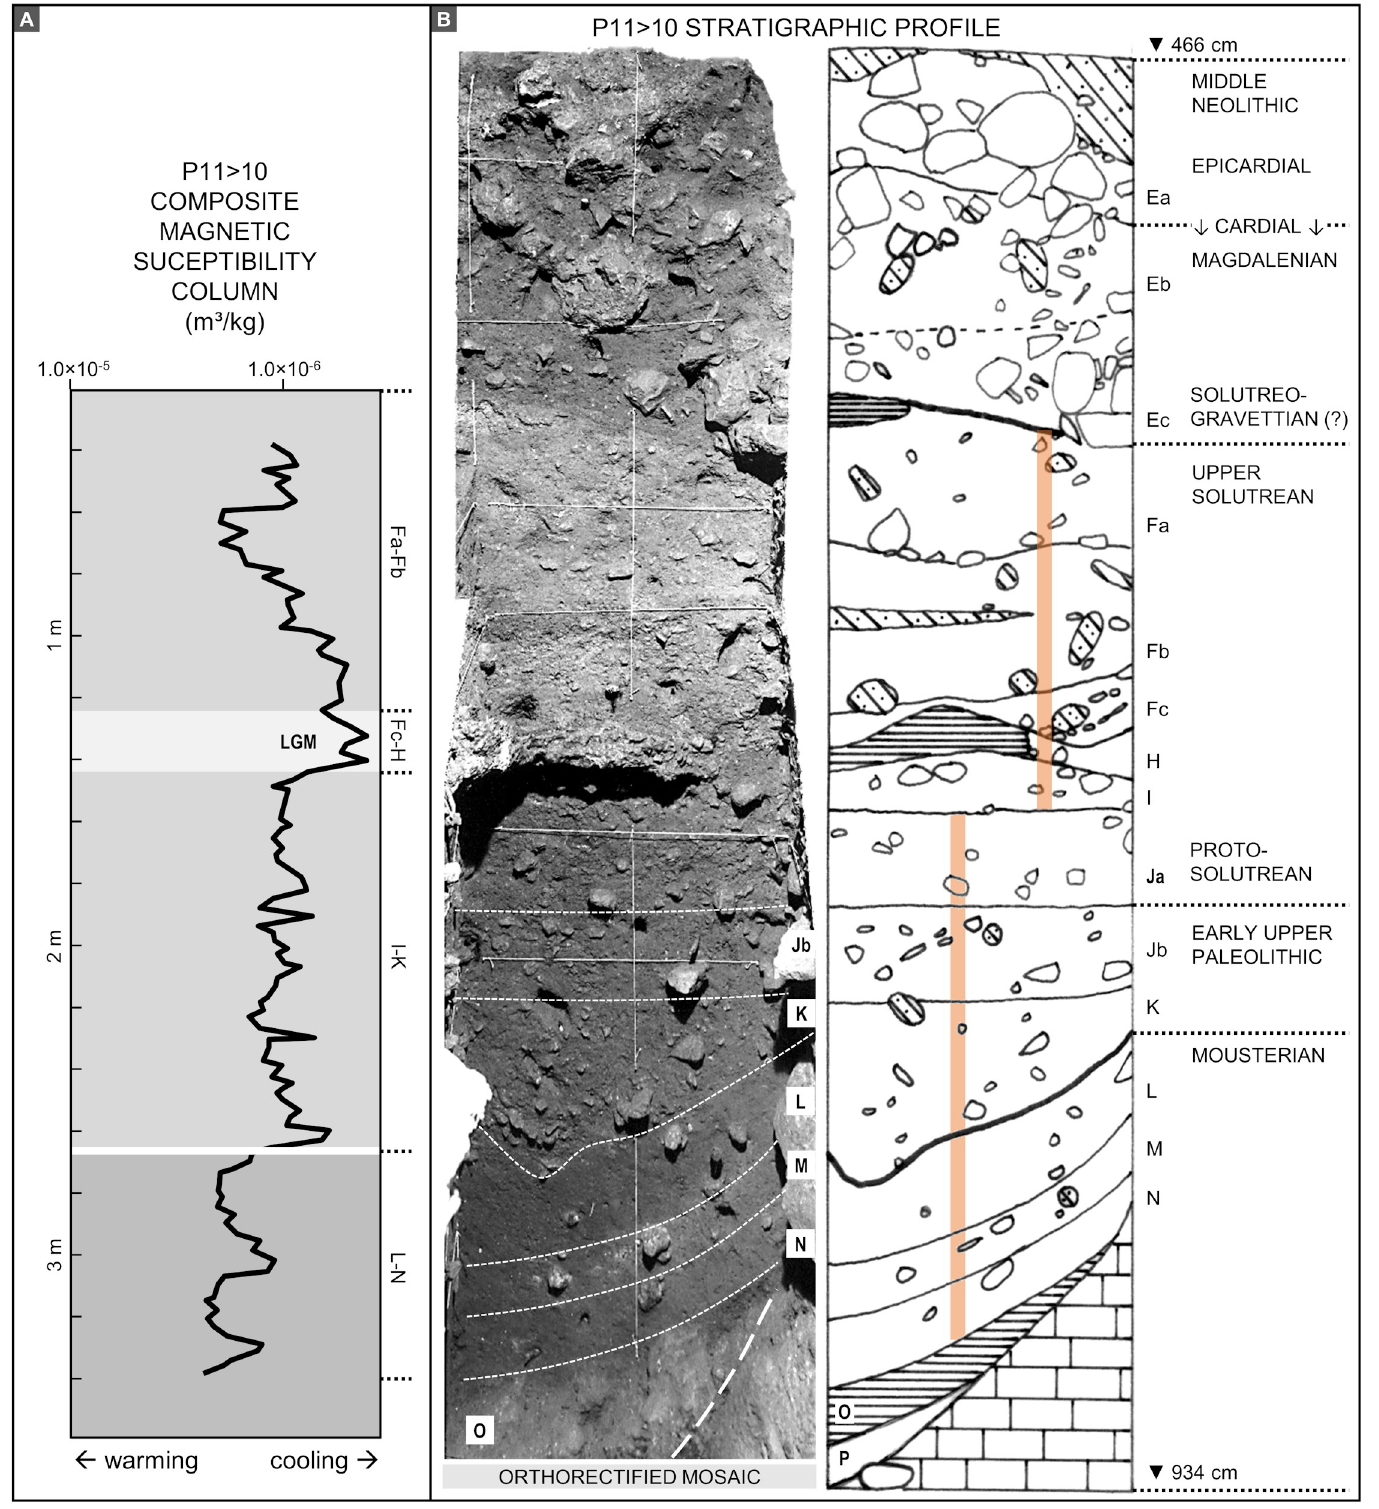
Fig 6. The archaeological sequence. A. Magnetic susceptibility curve (log scale) [2, 29]. B. Orthorectified photo mosaic and stratigraphic interpretation of the P11 > 10 profile (based on an original field record drawn at 1:10; elevations are below datum); the colour bands indicate the position of the magnetic susceptibility sampling